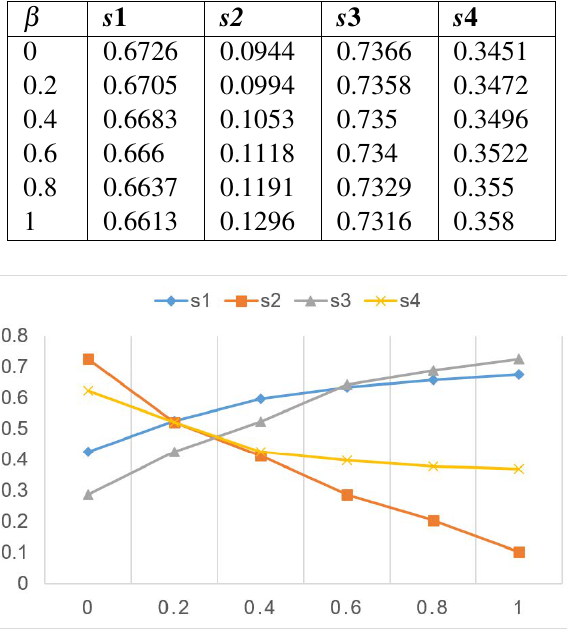
Fig. 2 The influence β on the ordering of the schemes